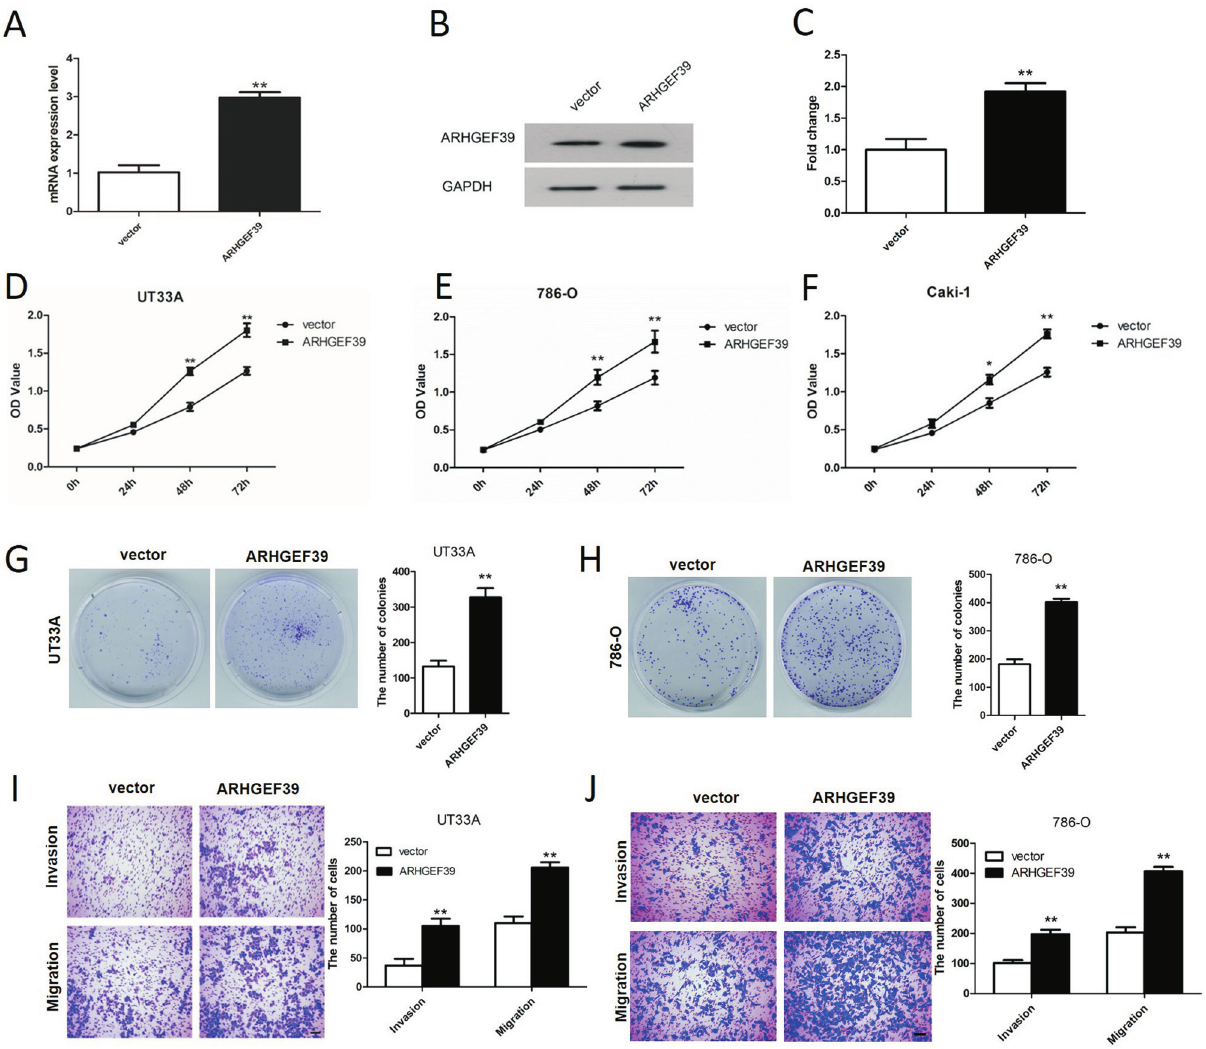
Figure4 -ARHGEF39overexpressionpromotedccRCCcellviability,migrationandinvasion. A) ThemRNAexpressionofARHGEF39inUT33Acells transfected with vector and pcDNA3.1-ARHGEF3 was analyzed by qRT-PCR assay, **p < 0.01. B-C) ARHGEF protein expression in UT33A cells transfected with vector and pcDNA3.1-ARHGEF39 was measured by western blotting assay, **p < 0.01. D-F) The viability of UT33A, 786-O and Caki-1 cells with up-regulated ARHGEF39 was determined by CCK8 assay, **p < 0.01. G-H) Clonogenic assay suggested that the viability of UT33A (G) and 786-O (H) cells in ARHGEF overexpression group was notably increased than that in empty vector group, **p < 0.01. I-J) Transwell invasion and migration assays were carried out to detect the motility of UT33A (I) and 786-O (J) cells transfected with empty vector and